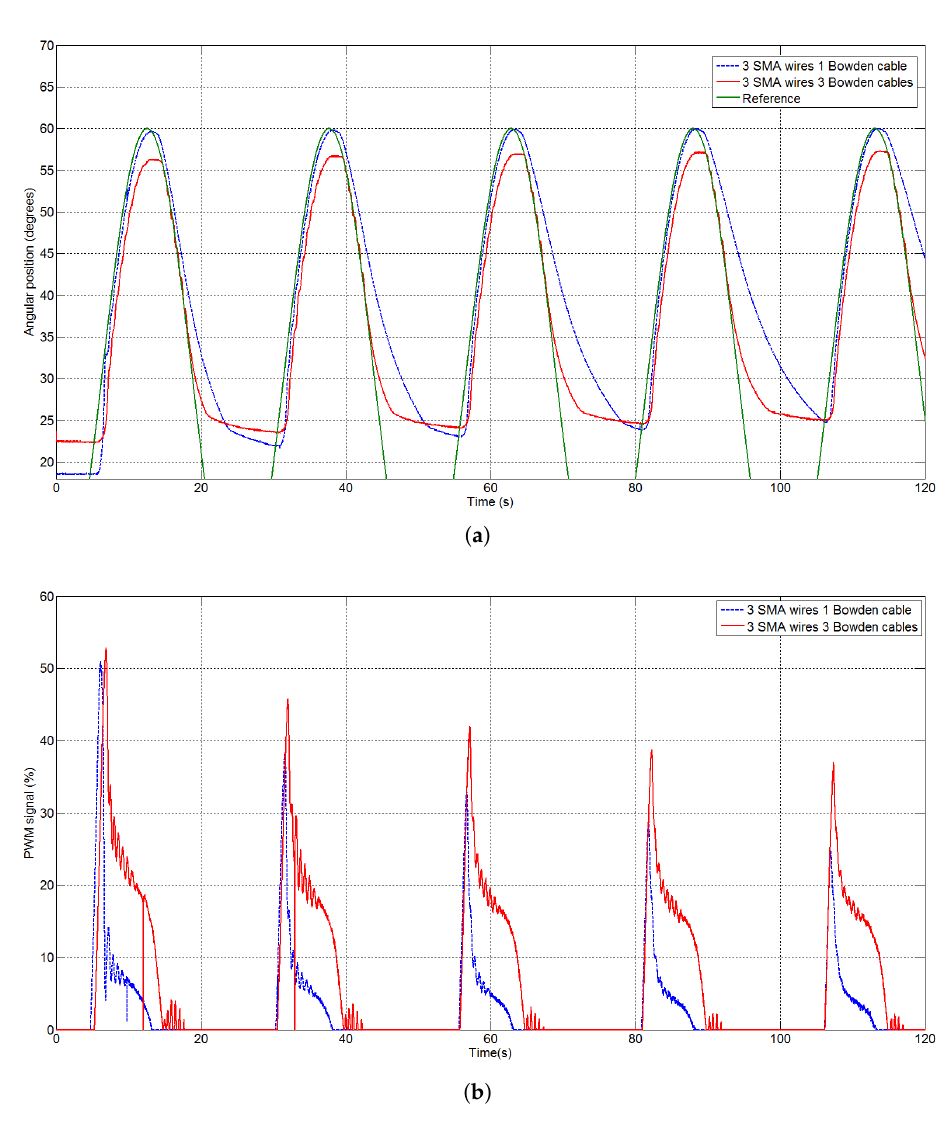
Figure 11. Multiple SMA wires actuator. ( a ) SMA based actuator position response, ( b ) PWM signals corresponding to SMA based actuator